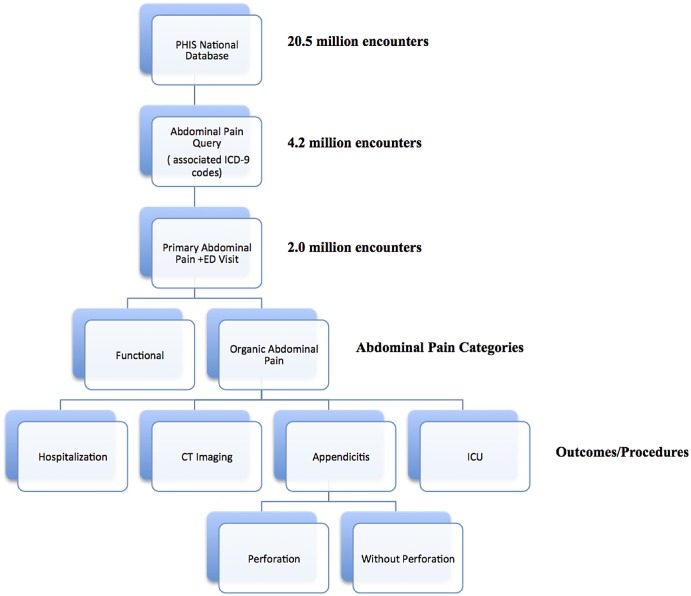
Summary of Study.